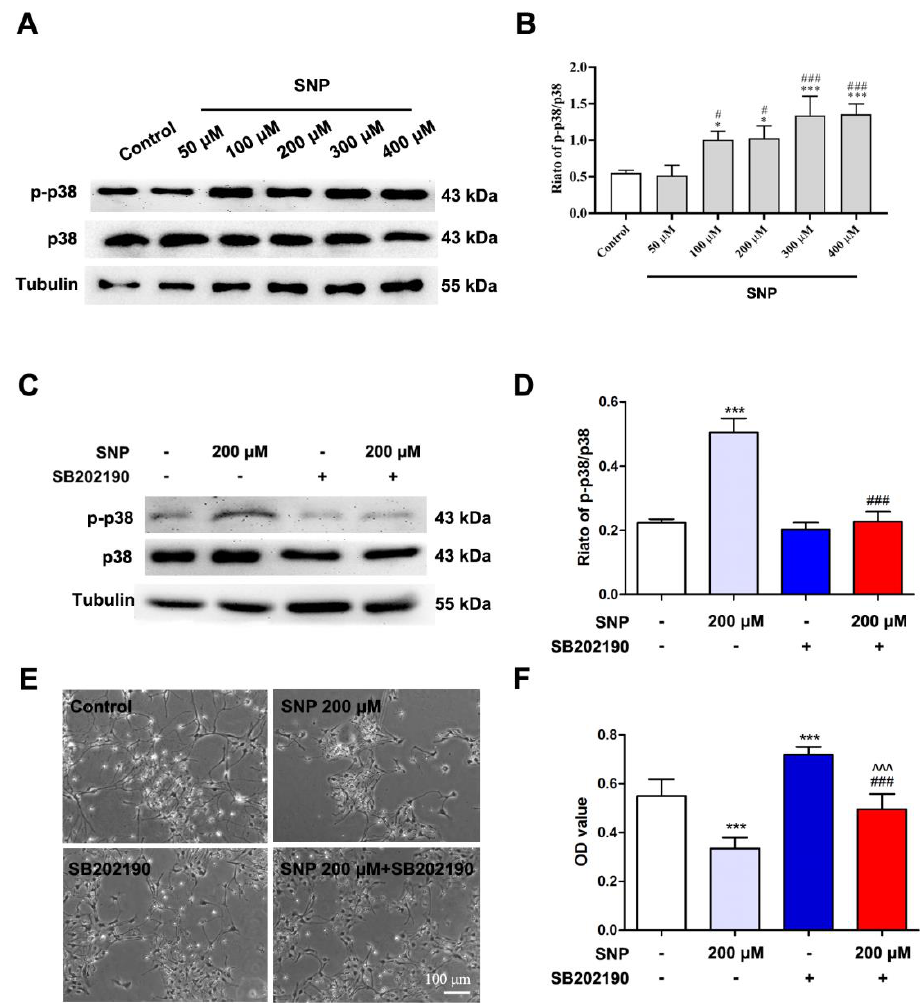
Figure 3. Effects of p38 on the survival of differentiated NSCs induced by SNP. ( A , B ) The expression of p38 and p-p38 of differentiated NSCs after SNP treatment. All data were obtained from three independent experiments and more than three replicates for every experiment. The values are the mean ± SD and were analyzed via a one-way ANOVA test. Compared with control * p < 0.05, *** p < 0.001; compared with the SNP 50 μM group # p < 0.05, ### p < 0.001, n = 3. ( C , D ) Expressions of p38 and p-p38 were detected after SNP and SB202190 treatment. ( E ) The survival and morphological changes of differentiated NSCs after SNP and SB202190 treatment. Scale bar = 100 μm. ( F ) Cell survival of differentiated NSCs after SNP and SB202190 treatment. All data of D and F were obtained from three independent experiments and more than three replicates for every experiment. The values are the mean ± SD and were analyzed via t -test. Compared with control *** p < 0.001; compared with the SNP 200 μM group ### p < 0.001; compared with the SB202190 group ^^^ p < 0.001, n = 5.